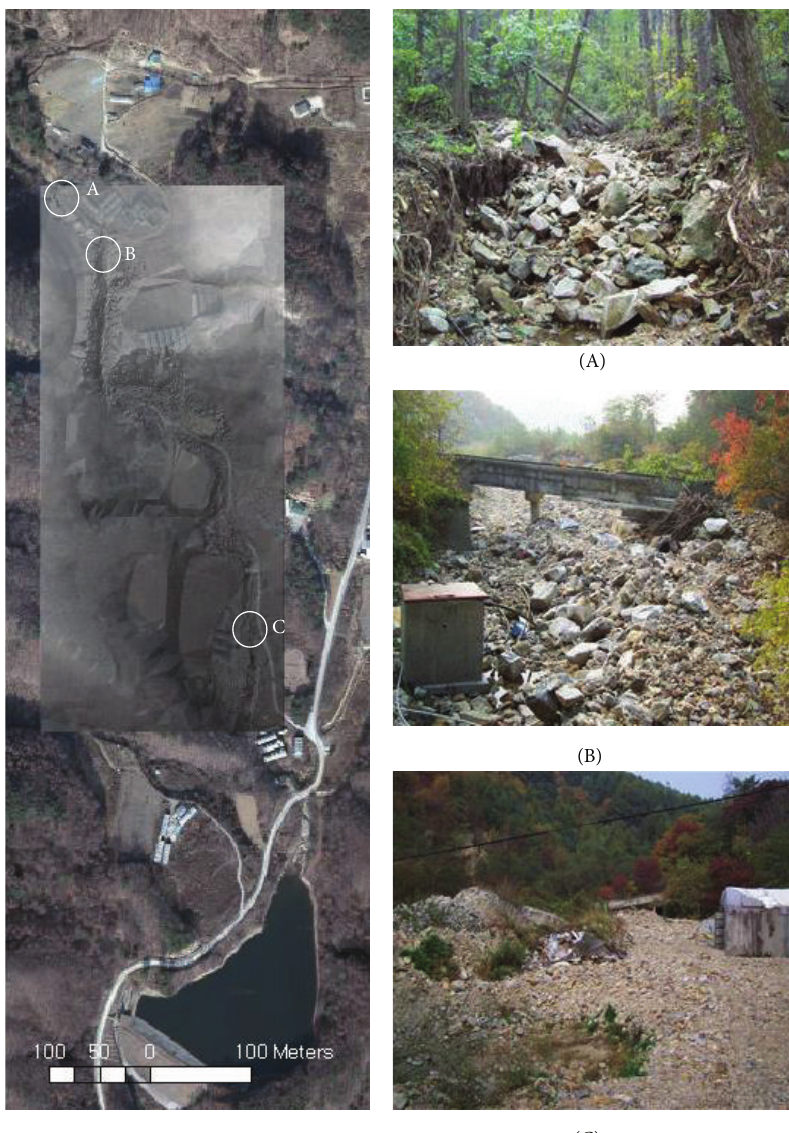
Figure 2: The aerial photograph in study area and terrestrial photograph showing flooding